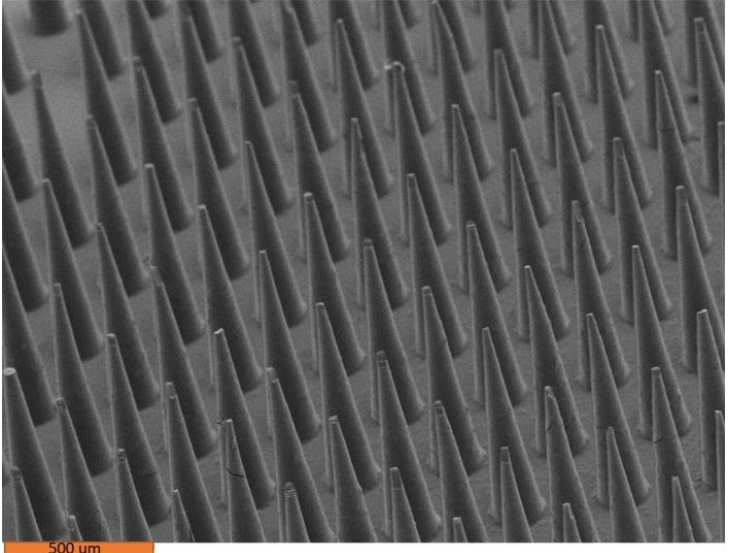
Figure 2. Scanning electron microscope image of 8% amphotericin B –Gantrez™ microneedles.